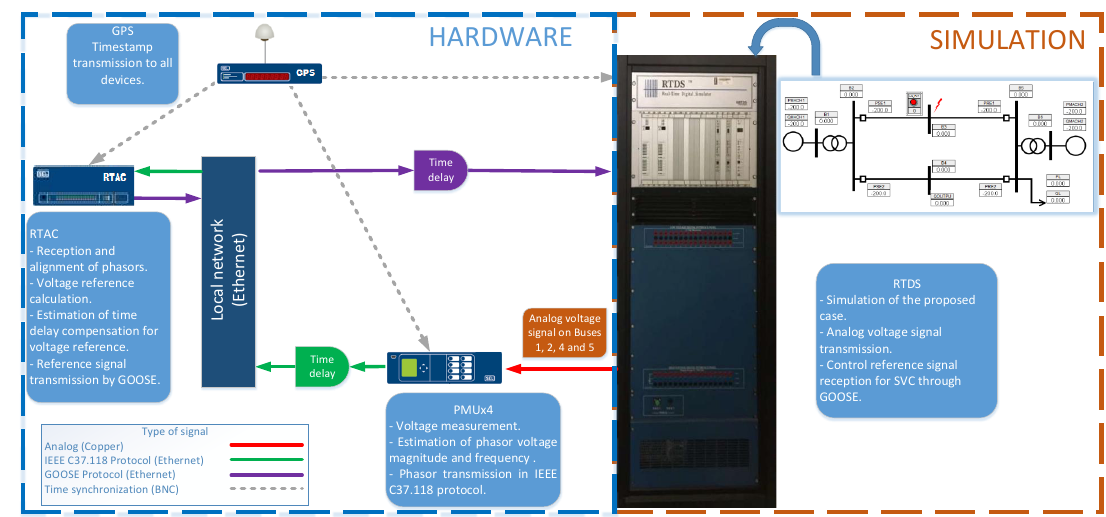
Figure 8. Schematic representation of the proposed HIL